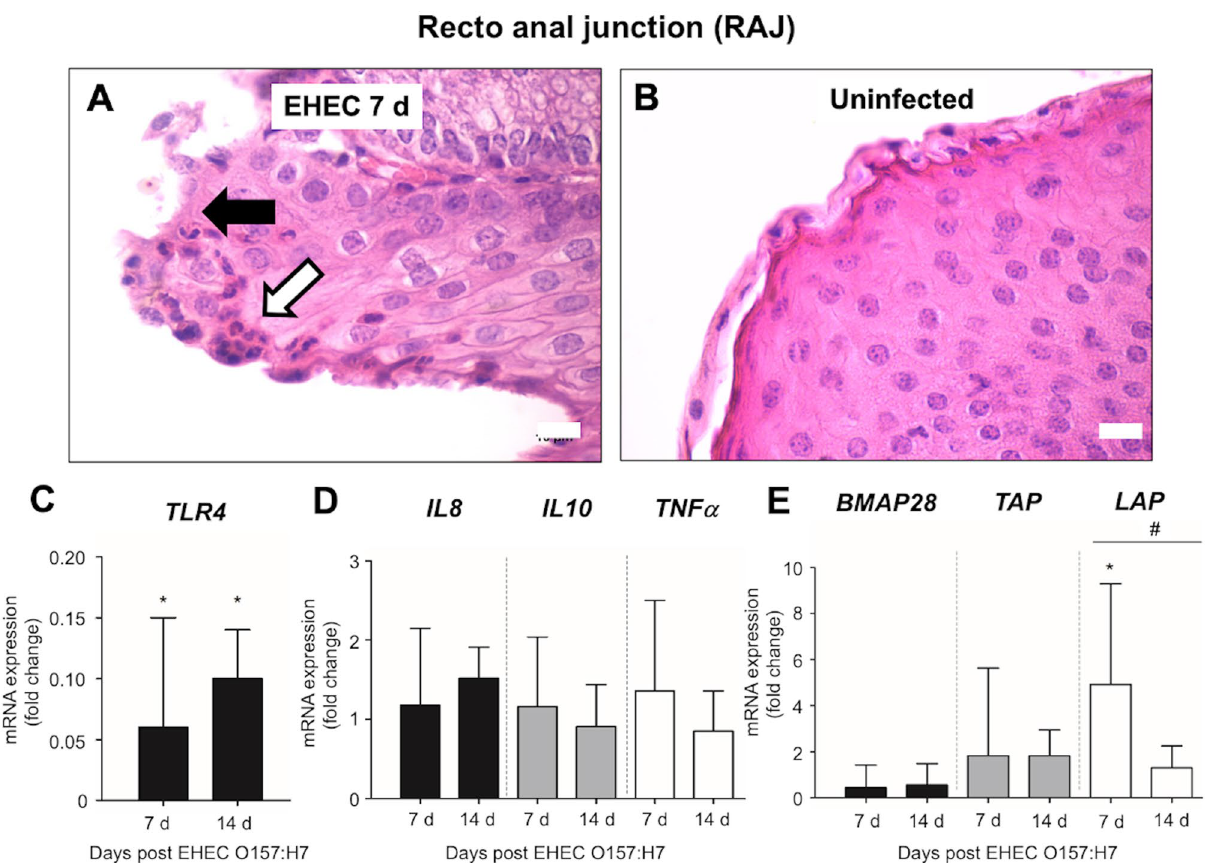
Figure 4. ( A-B ) Microphotographs (hematoxylin and eosin stain) of rectoanal junctions (RAJs) of ( A ) calves infected by EHEC O157: H7 (EHEC) 7 d post-challenge showing detached and sloughing epithelial cells (black arrow) and intraepithelial neutrophils (white arrow), and ( B ) uninfected calves with intact epithelium (400x, bar = 100 µm). Transcriptional gene expression of ( C ) TLR4 , ( D ) IL8, IL10 and TNF ɑ , and ( E )